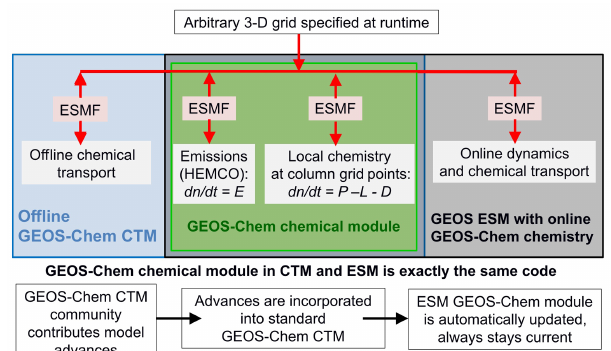
Figure 1. Schematic of GEOS-Chem chemical module used either offline as a chemical transport model (CTM) or online in an Earth system model (ESM), with interfaces managed through the Earth system modeling framework (ESMF). The module is grid indepen- dent, with individual computations done on atmospheric columns at user-selected grid points. It computes local changes in concen- trations with time (d n/ d t ) as a result of emissions ( E ), chemi- cal production ( P ), chemical loss ( L ), and deposition ( D ). Emis- sions are handled through the Harvard-NASA EMission COmpo- nent (HEMCO) to provide ESM users the option of only integrating